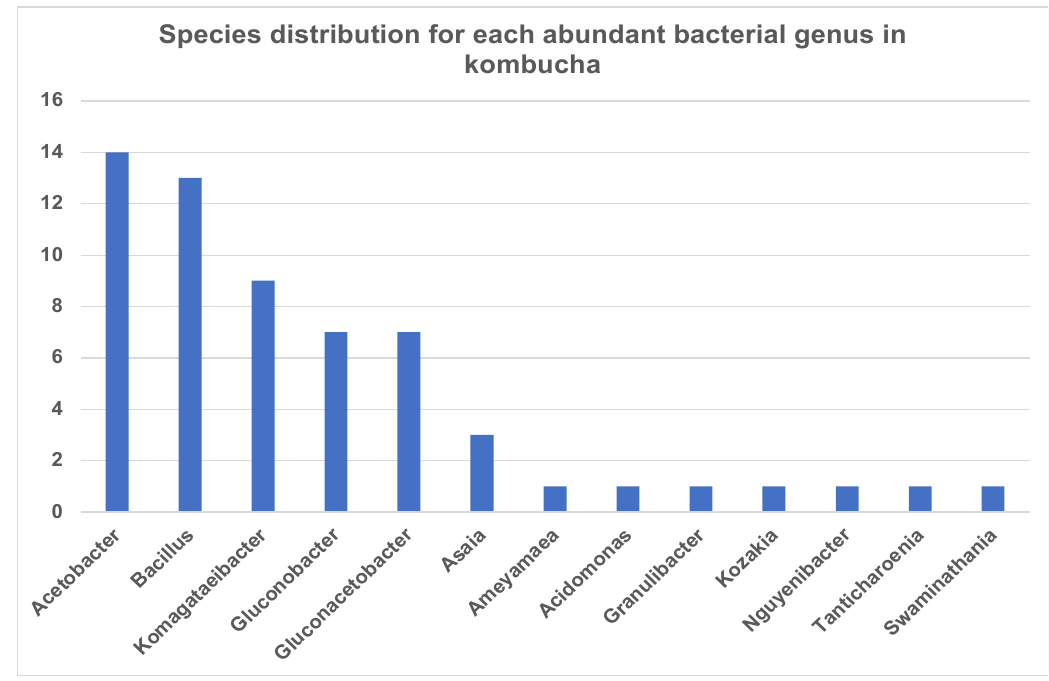
Figure 2 . Number of bacterial species each abundant genus has in kombucha. Acetobacter genus has 14 different species; Bacillus genus has 13 different species; Komagataeibacter genus has 9 different species in kombucha samples.